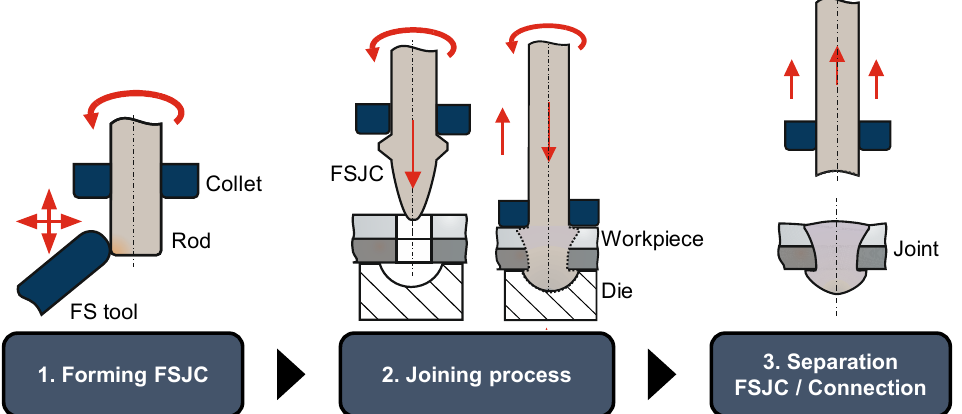
Figure 1. Process principle of the adaptive joining technology employing FSJC with pre-holed workpieces.